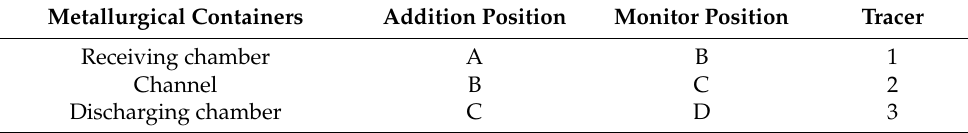
Figure 3. The schematic structural diagram of measurement method of RTD. Table 6. Simulation performed for the individual unit